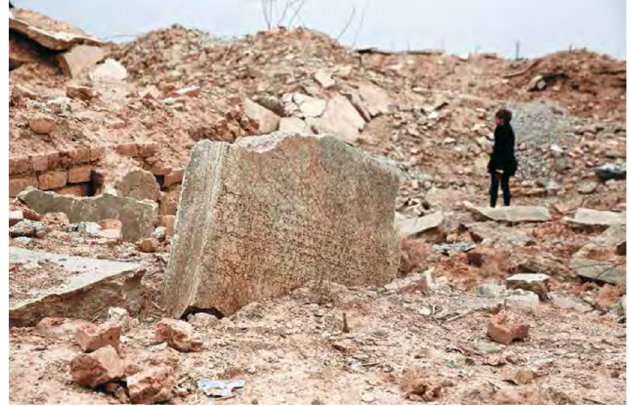
Fig. 1. Amidst the rubble a damaged stone tablet with cuneiform writing